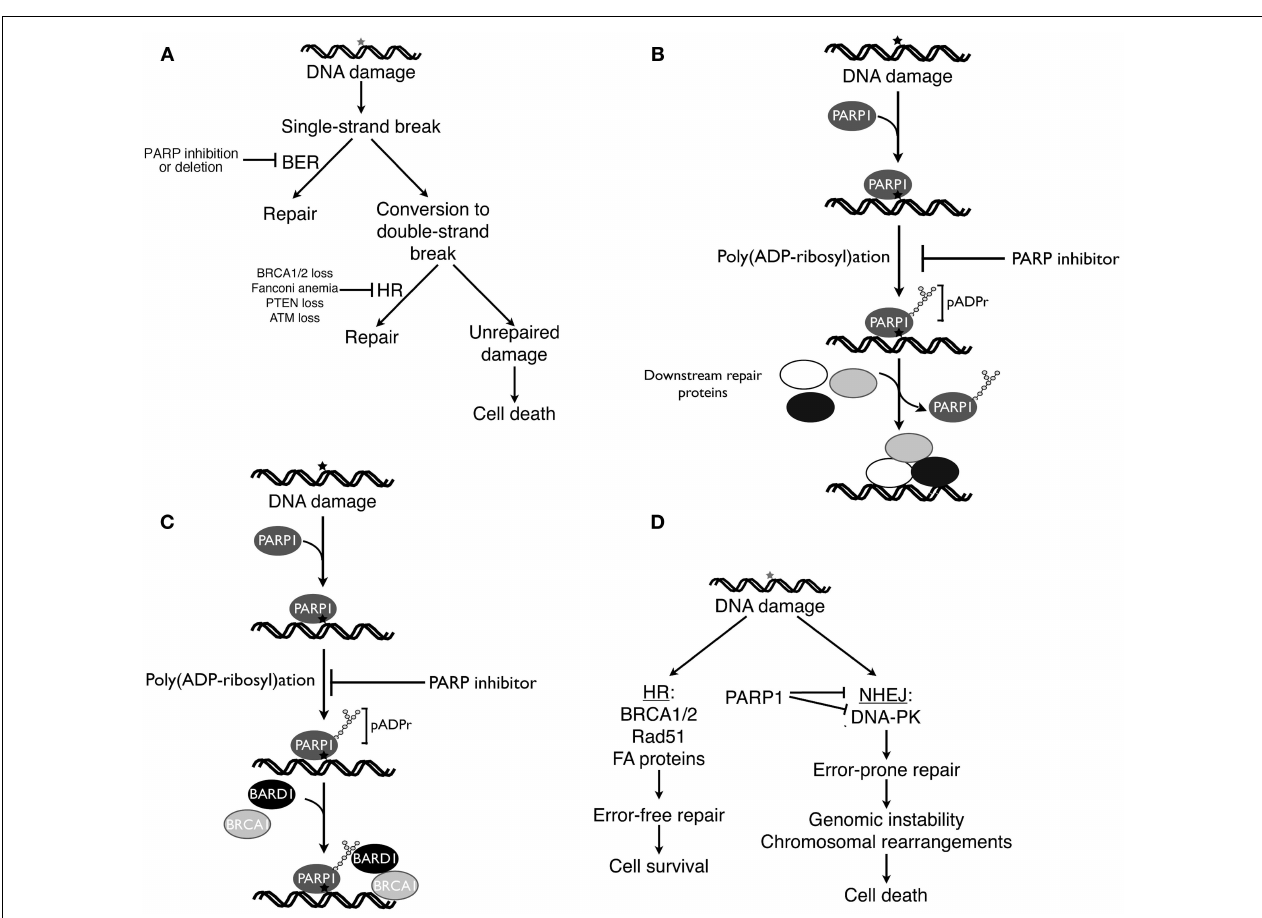
of mutated BRCA1 in the presence of PARP inhibitors. As described by Li and Yu (134), recruitment of BRCA1 to DNA double-strand breaks requires both rapid binding of the BRCA1 binding partner BARD1 to pADPr and subsequent binding of a BRCA1-containing complex to phosphorylated H2AX at the break. Mutations that impair recruitment of the BRCA1-containing complex to phosphorylated H2AX render BRCA1 localization to sites of damage more dependent on the BARD1-pADPr interaction and, therefore, more sensitive to PARP inhibitors. (D) , model emphasizing the role of activated NHEJ in PARP inhibitor killing.When DNA double-strand breaks occur, HR preferentially repairs them. In HR-deficient cells, however, double-strand breaks are more frequently repaired by the error-prone NHEJ pathway, resulting in mutations, chromosomal rearrangements, and NHEJ-mediated cell death. PARP inhibitors accelerate this process by removing a brake on NHEJ (116). (A,D) are modified from Patel et al.